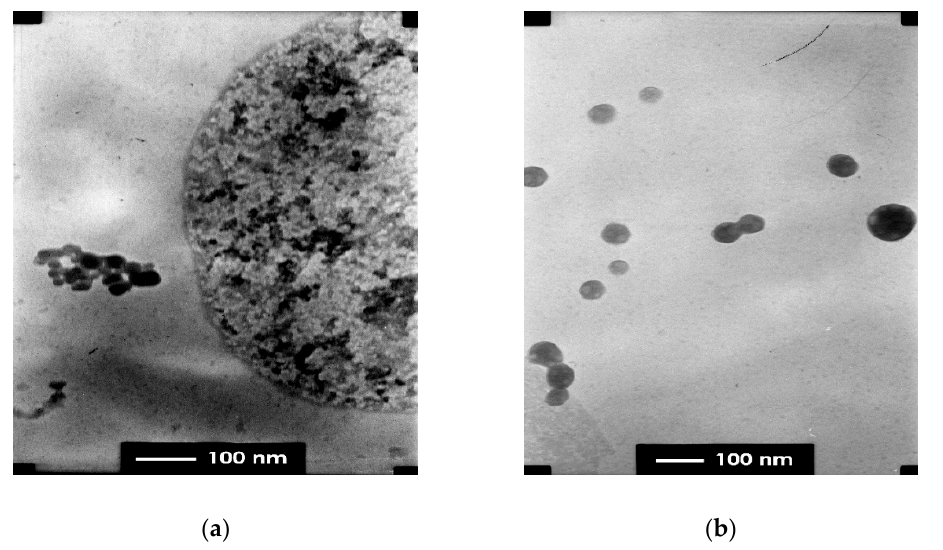
Figure 4. TEM photographs of G0 ( a ) and G1 ( b ) powders. EDX analyses of all samples were carried out at six different points and revealed a similar elemental composition. Zinc, oxygen, and carbon only without any other elements were registered in the spectrum of the reference samples (Figure 5).